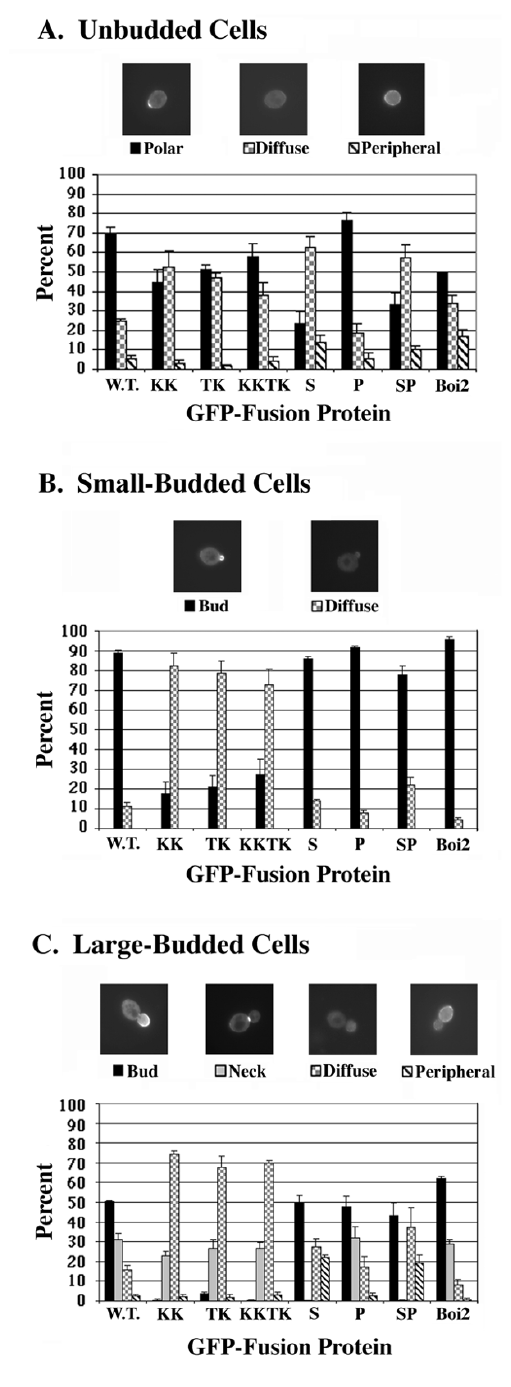
Figure 8 Localization patterns of GFP fusions to different versions of Boi1 and to wild-type Boi2. Parts A-C show analyses for unbudded, small-budded, and large-budded cells, respectively. Micrographs are examples of different patterns of localization of Boi1-GFP. Bars indicate percentages of cells that displayed each of these patterns. In Part C, "peripheral" means localization around the periphery of the mother part of the cell. GFP fusions to the different versions of Boi1 are encoded by the following plasmids: W.T. (wild-type) (pPB1307), KK (pPB1347), TK (pPB2007), KKTK (pPB1689), S (pPB1392), P (pPB1394), and SP (pPB1396). Boi2-GFP ("Boi2") was encoded by plasmid